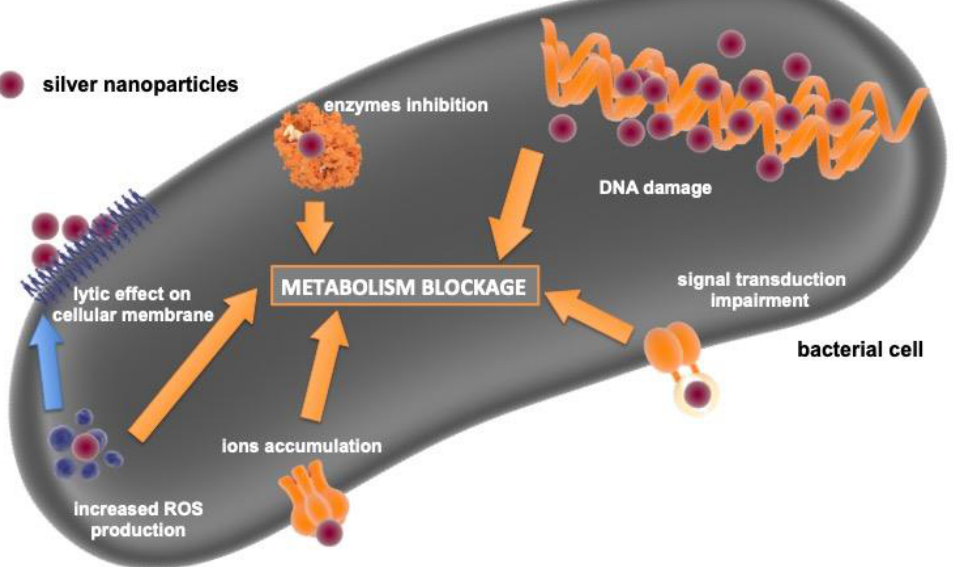
Figure 3. Schematic summary of AgNPs antibacterial activity mechanism.